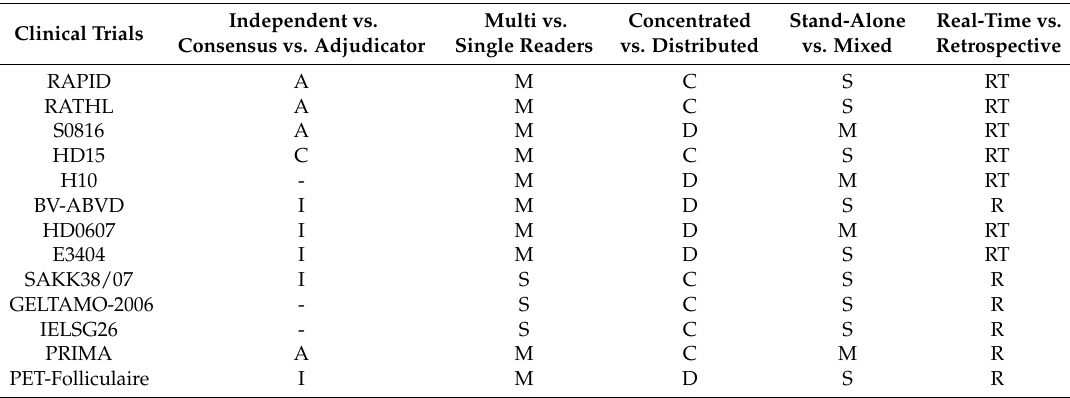
Table 1. Categories of central review used by the clinical trials analysed in this manuscript. Independent vs. Clinical Trials Consensus vs. Adjudicator